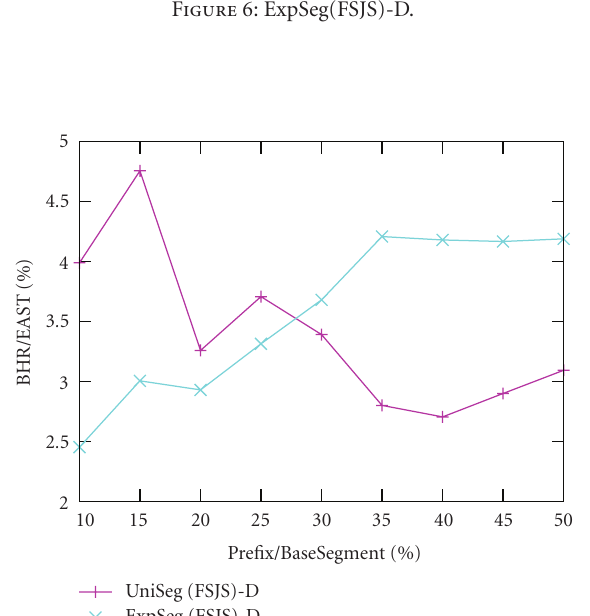
Figure 6: ExpSeg(FSJS)-D.